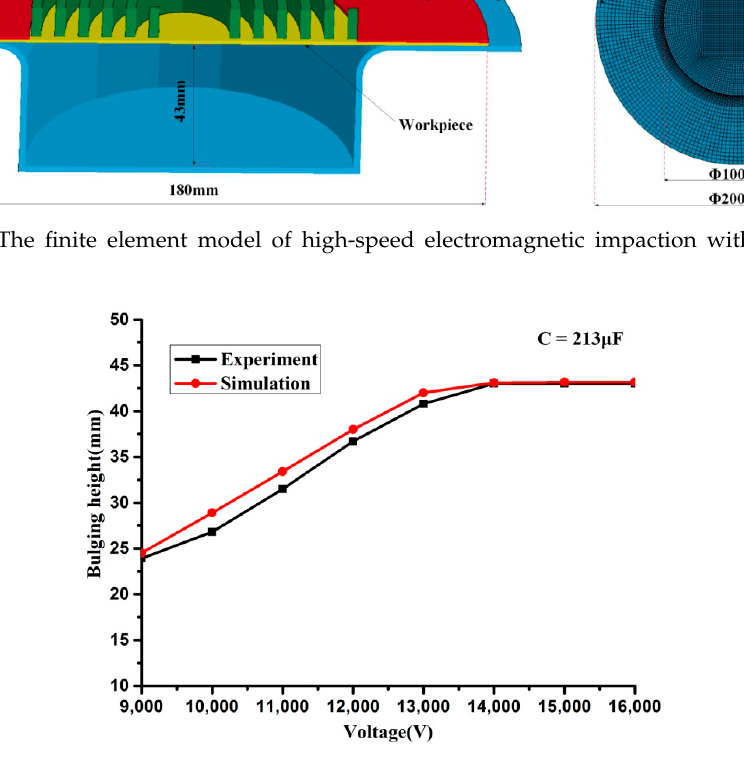
Figure 23. The relationship between discharge voltages and bulging heights.